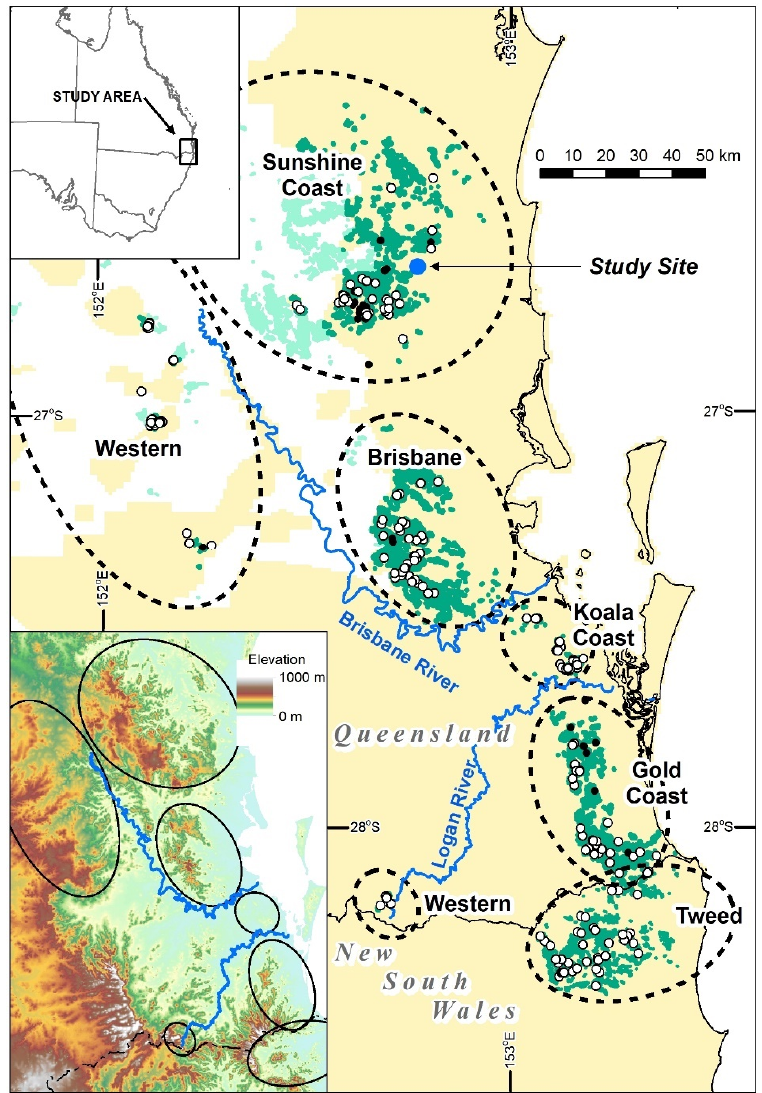
Figure 1. We examined a forest community used by koalas (Regional Ecosystem 12.11.3) occurring across Southeast Queensland and the New South Wales north coast (Tweed). Within this study area, six distinct subregions (dotted black ellipses) of RE 12.11.3 can be recognised by spatial proximity or separation by rivers or state borders. We selected the Koala Coast to examine the intra ‐ subregion canopy height variability (Figure 3) and an additional site on the Sunshine Coast to examine the height variability resulting from historical forest disturbances (blue dot; see Figure 4). ALS coverage is shown (pale yellow background); vegetation community RE 12.11.3 is covered by ALS (dark green, with similar areas in NSW), and RE 12.11.3 not covered by ALS (light green). Random plots (205) within ALS ‐ covered RE 12.11.3 (white circles) and CORVEG plots (33) within ALS ‐ covered RE 12.11.3 (black circles) are shown.